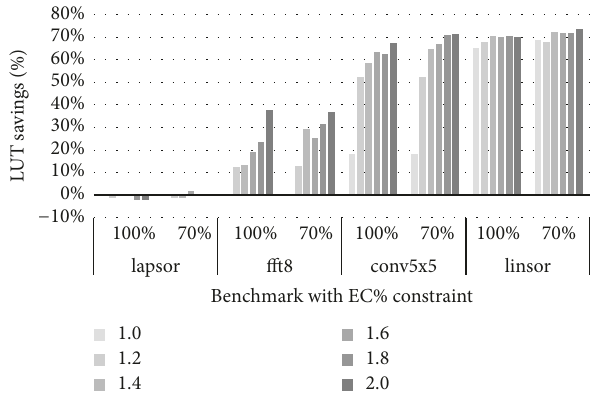
Figure 6: Resource savings of FD-FTA heuristic under different normalized latency constraints for selected benchmarks and EC% constraints when compared to